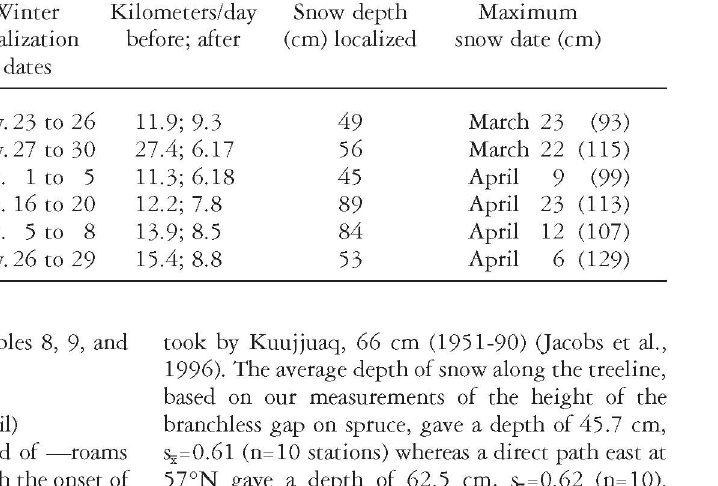
Table 7. Role of snow cover on mobility rates and winter localizations.